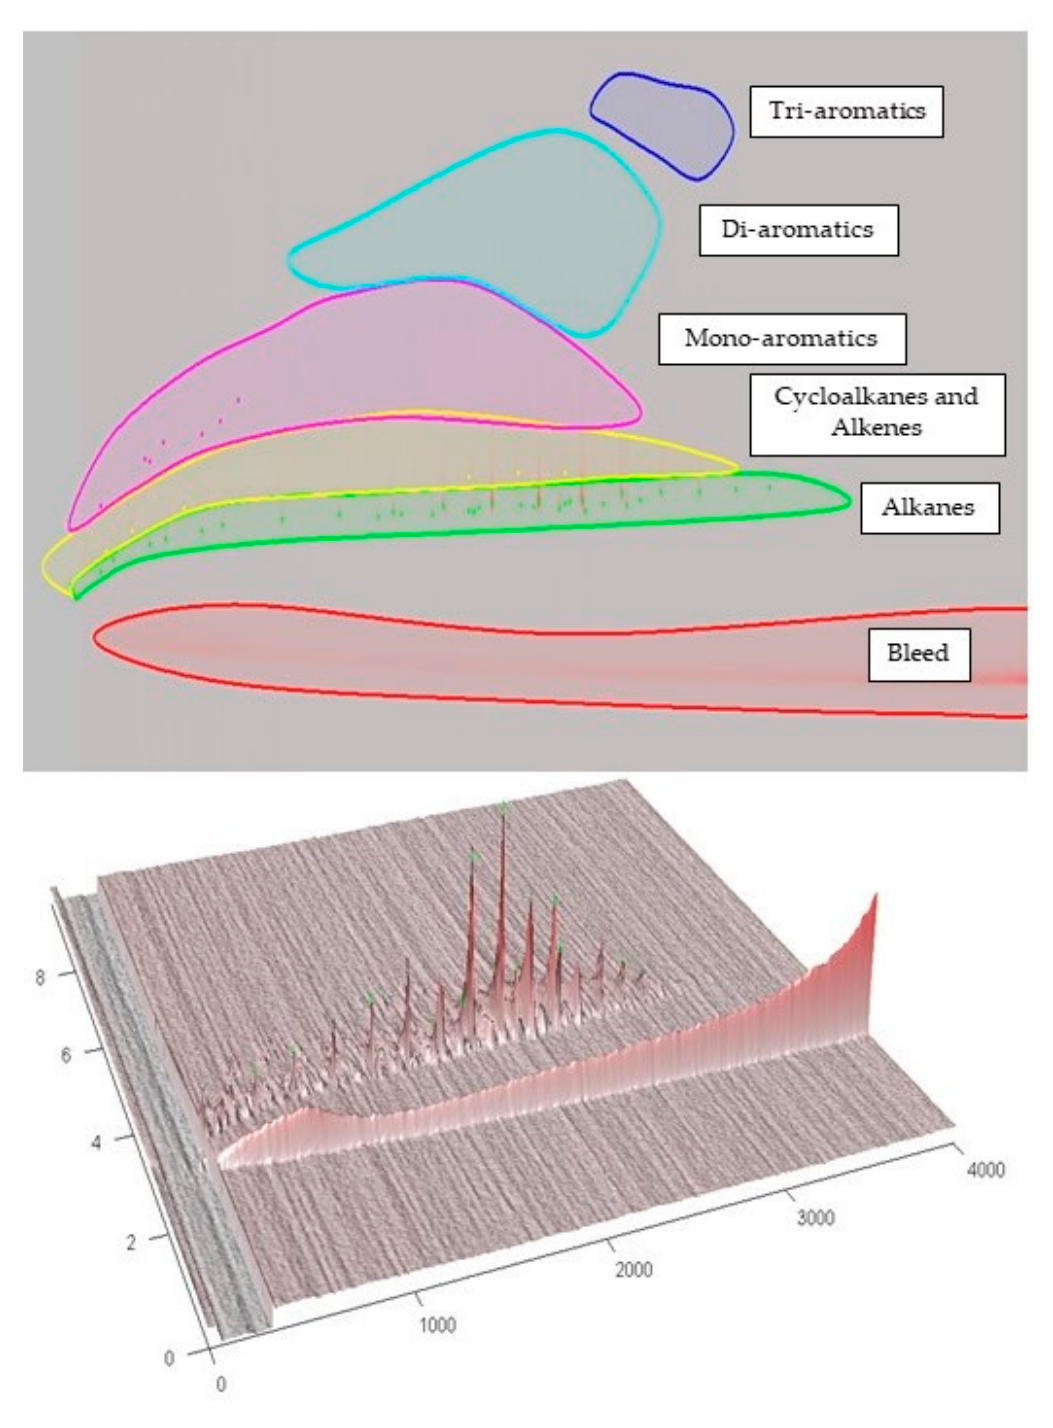
Figure 9. Average sample after the deactivation procedure type 1.